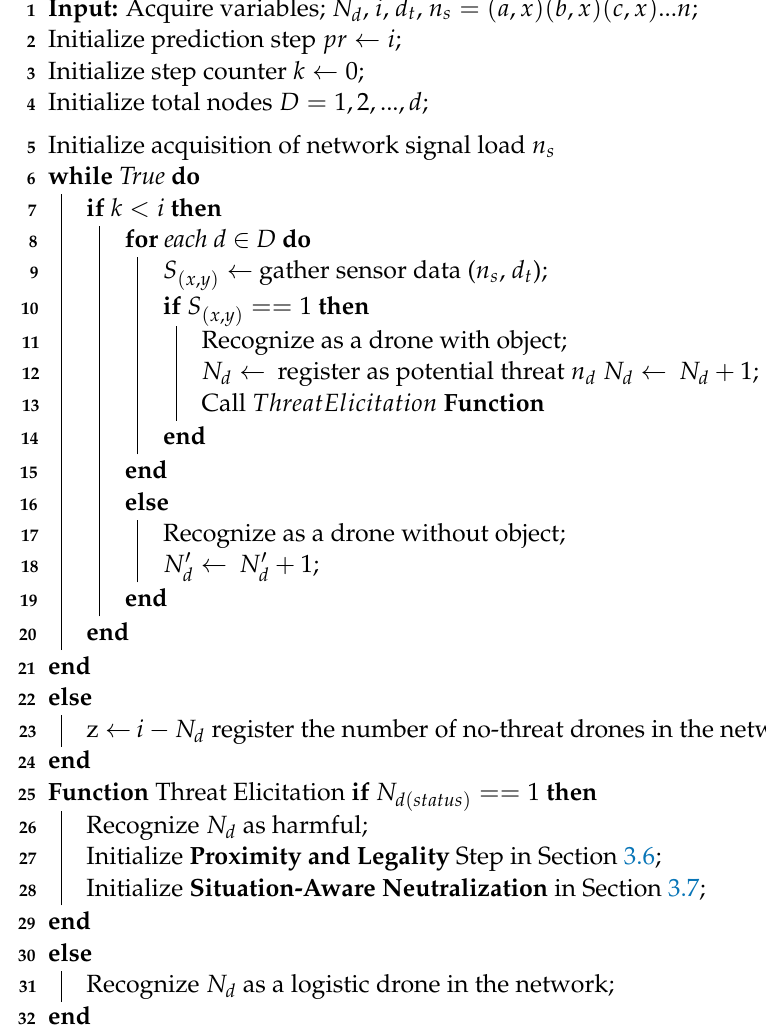
Algorithm 2: Harmful Object Recognition and Elicitation ( D rd λ